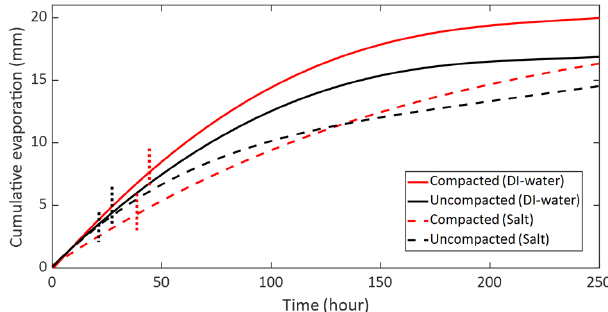
Figure 11. Cumulative evaporation for the compacted and uncom- pacted sand samples for conditions of DI water (solid lines) and saline solution (dashed lines). Vertical dotted lines indicate the tran- sition from S1 to